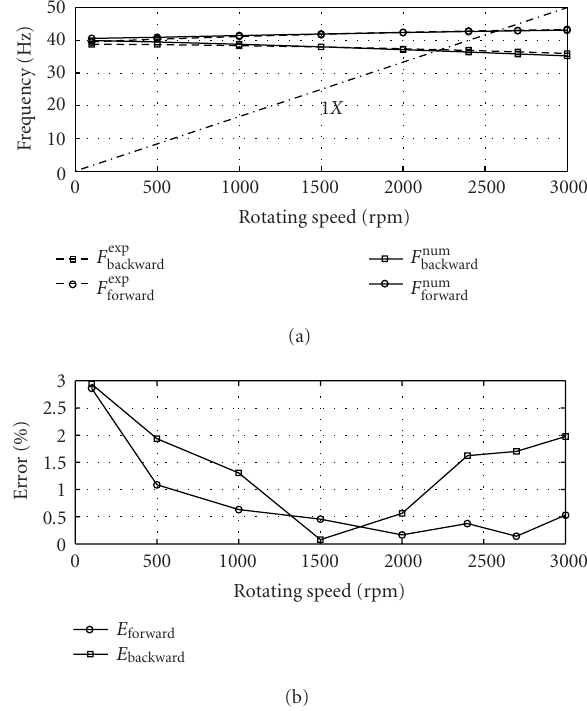
Figure 20: The relative errors between the experimental and nu- merical values of the backward and forward modes in function of the rotating